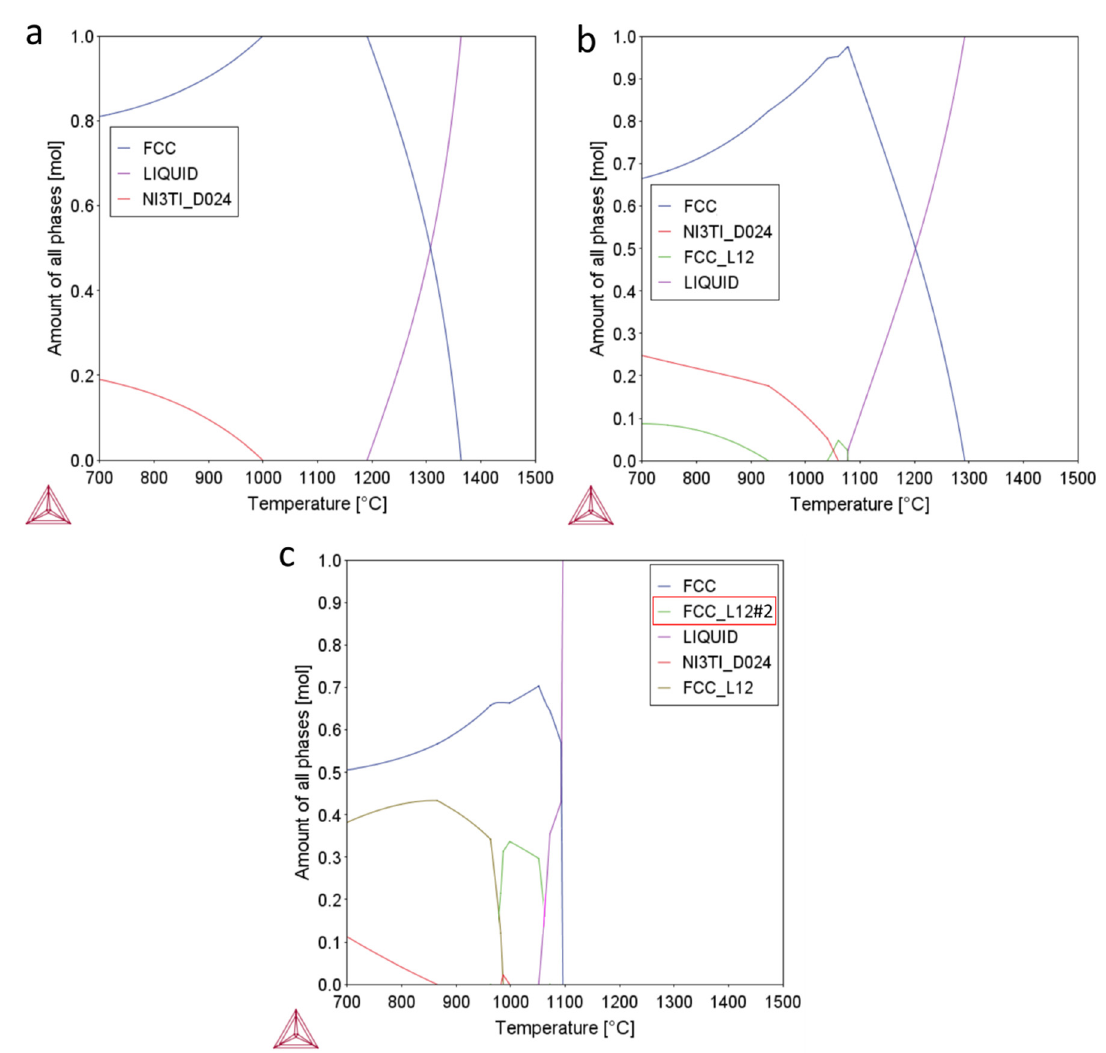
Figure 2. Results of the CALPHAD predictions of Ni1.5Co1.5CrFeTix alloys showing equilibrium phases and their respective fraction at different temperatures; ( a ) Ti0.3; ( b ) Ti0.5; ( c ) Ti0.7.